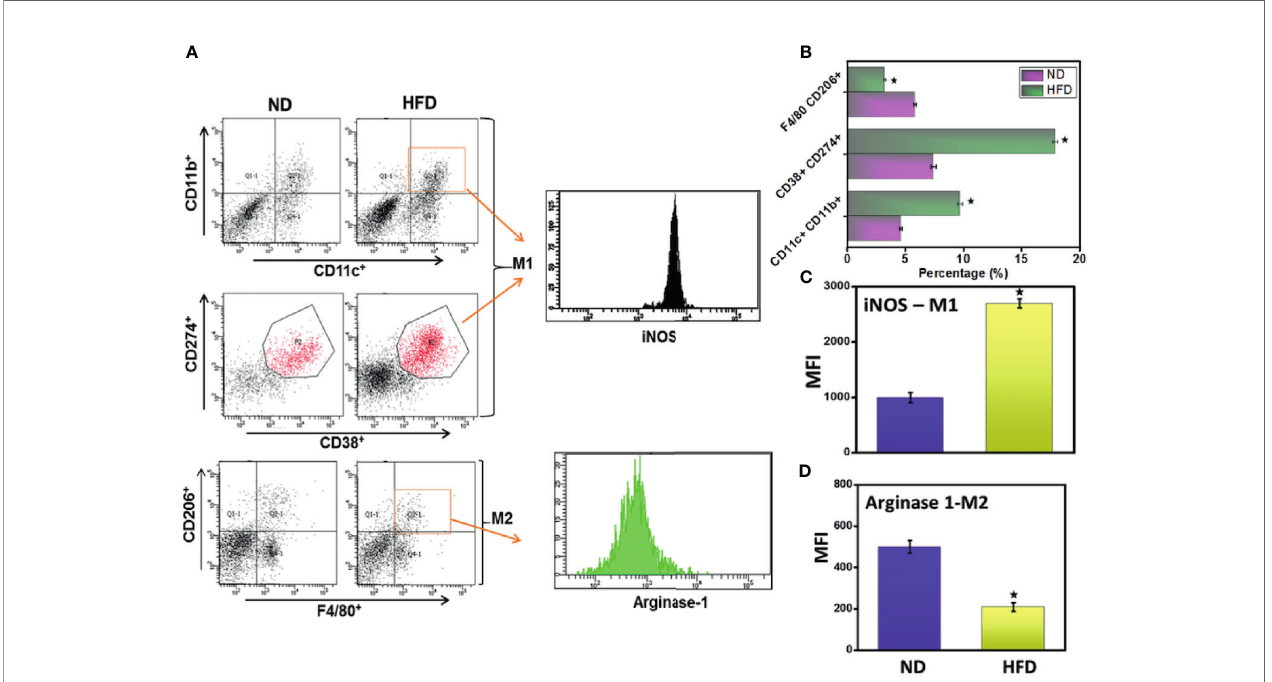
FIGURE 7 | DIO mediates the macrophage frequency and polarization in adipose tissue. The adipocytes were isolated from the two groups of mice after 16 weeks. Changes in the frequency of M1 (iNOS positive cells, upper panel A , B ), M2 (Arginase-1 positive cells, lower panel A , B ), and mean fl uorescence intensity (MFI) of both iNOS and Arginase-1 (C, D) were determined by fl ow cytometry and expressed as the mean percentage of cells/mice ± SEM. The cumulative data of dot plot and histogram are shown from a total n=18 representative experiment. The percentage change is shown by combining the mean of the three independent experiments involving six mice per group yielded similar results. *p < 0.05, unpaired student ’ s t-test indicates statistically signi fi cant differences in MFI and frequency of iNOS (M1) and arginase-2 (M2) between ND and HFD